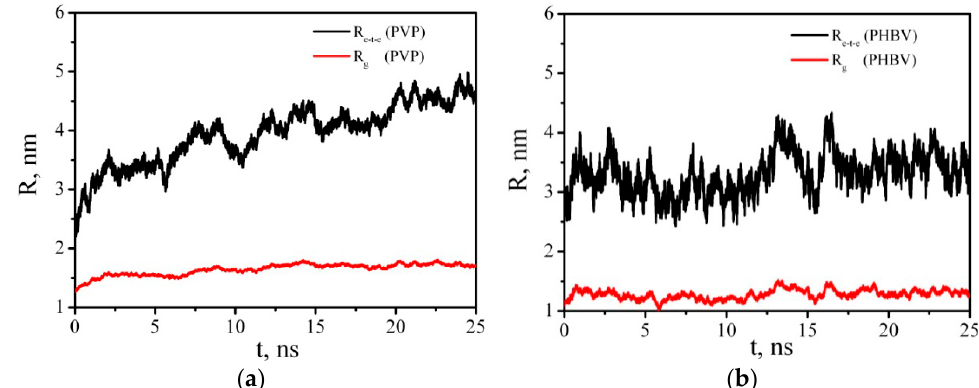
Figure 17. Time dependence of the end-to-end distance R e-t-e and radius of gyration R g of PVP ( a ) and PHBV ( b ).